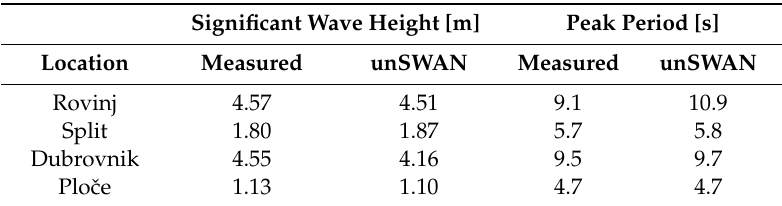
Table 3. Comparison of the wave parameters (significant wave, height, and peak period) measured by the Croatian Hydrographic Institute at four di ff erent locations (Rovinj, Split, Dubrovnik and Ploˇce) together with the AdriSC unSWAN model results during the peak of the storm on 29 October 2018.